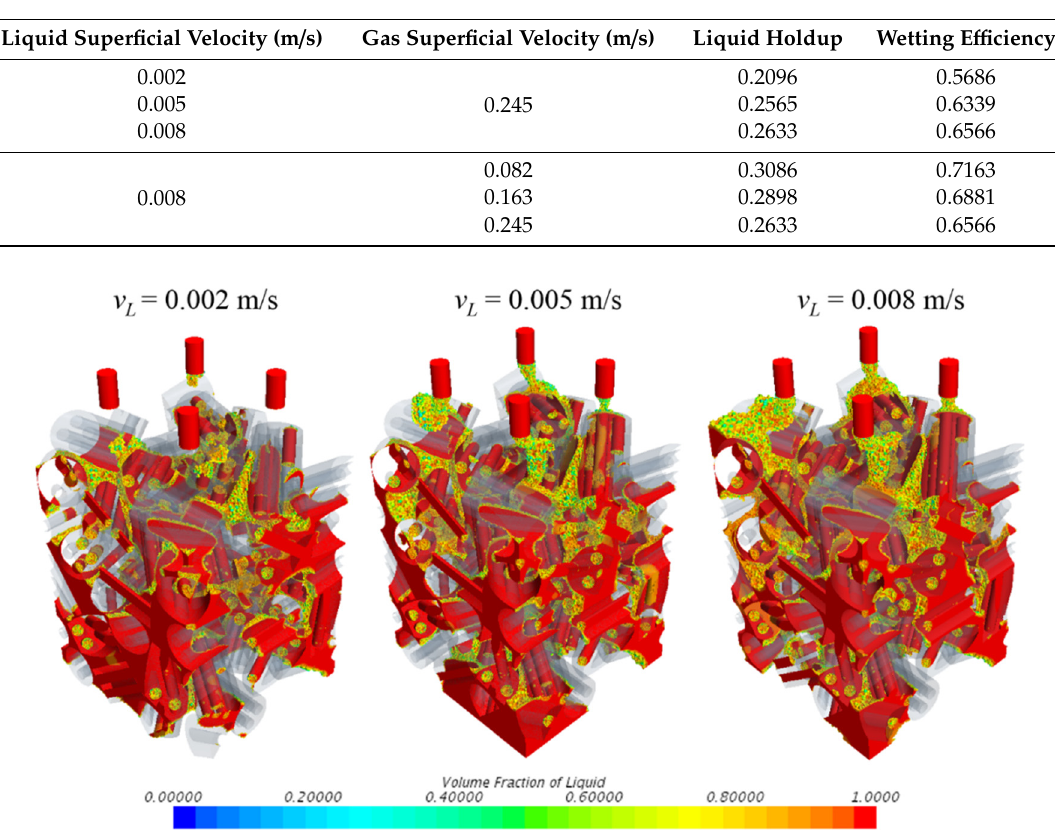
Table 9. Liquid holdup and wetting e ffi ciency at di ff erent liquid and gas velocities.